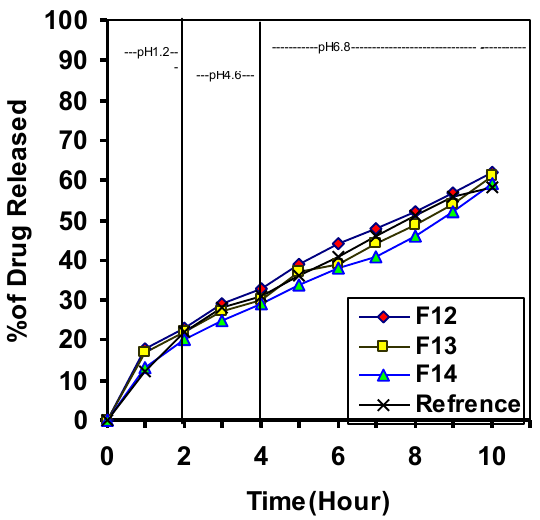
Figure 5. Effect of Ethylcellulose (EC) addition on the cumulative released of PTX from tableted matrix at different pH- medium.